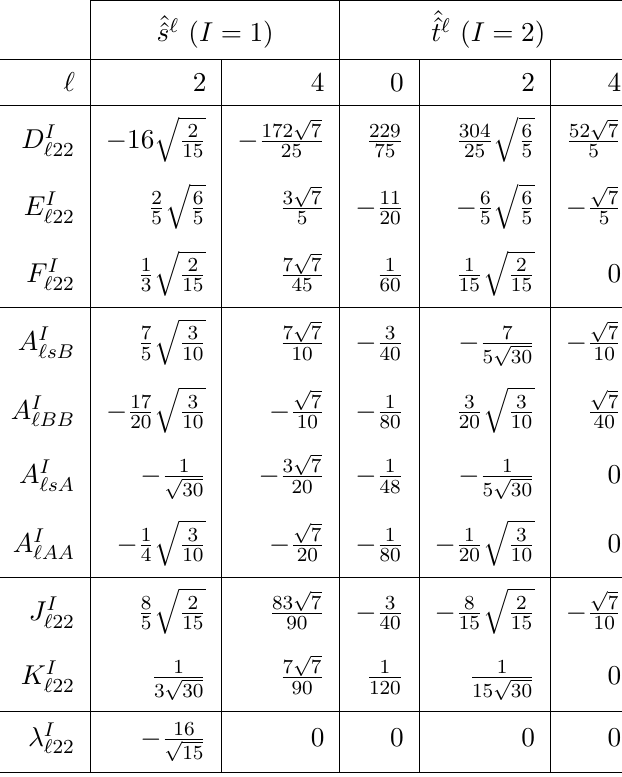
Table 6. Numerical coefficients in equations (A.23)–(A.28). Notice that our numerical coefficients differ with respect to those given in [29]. More precisely, all the non-zero coefficients for ‘ = 2 or ‘ = 4 differ by the same factor, 4 p 2 / 5 and p 7 / 5 respectively, compared to the corresponding coefficients in that paper. This is due to the fact that we use a different harmonic representation, which also includes odd values of ‘ . The coefficients are the same for ‘ = 0 . For ‘ odd all coefficients